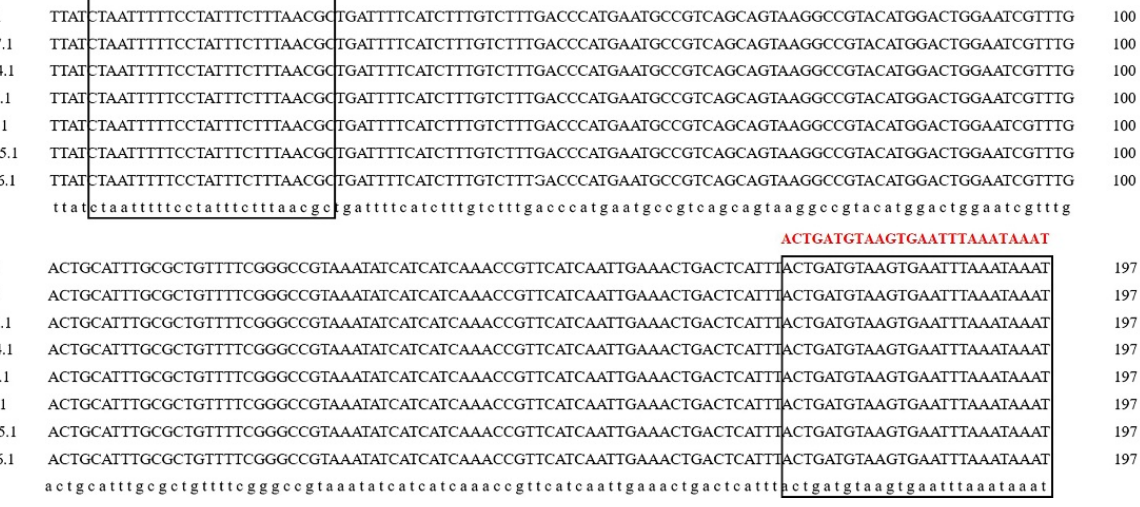
Figure 1. Specific primer of gene D3N19_RS13500 existed in many B. velezensis strains. The red fonts indicate the primer sequence. The black fonts indicate the corresponding gene sequence in different B. velezensis strains (including ZF2, K01, GY65, LDO2, LG37, LS69, JTYP2 and ZF145).